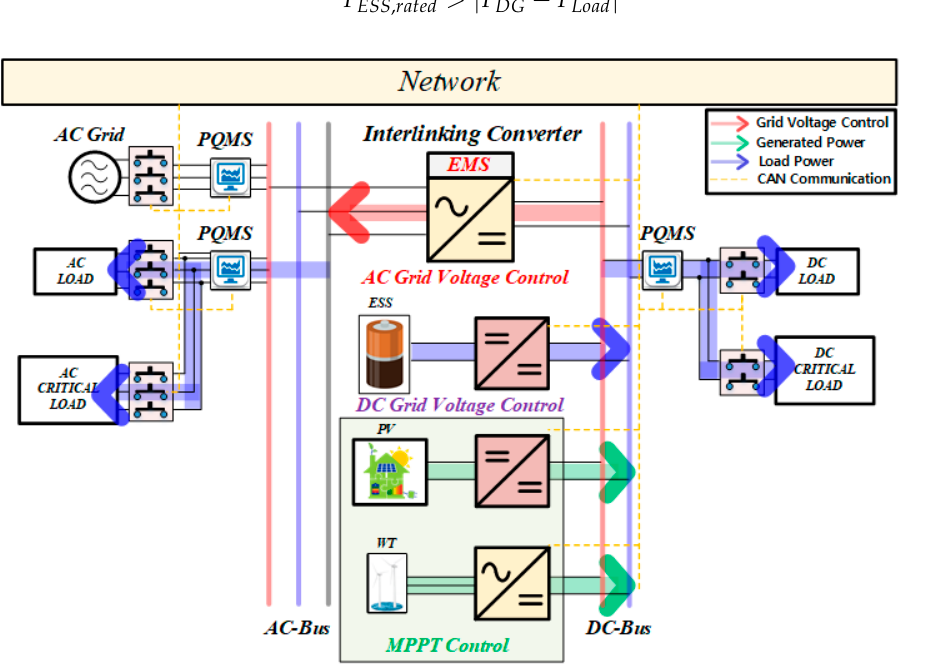
Figure 10. Power flow diagram of the stand-alone mode (mode 4).